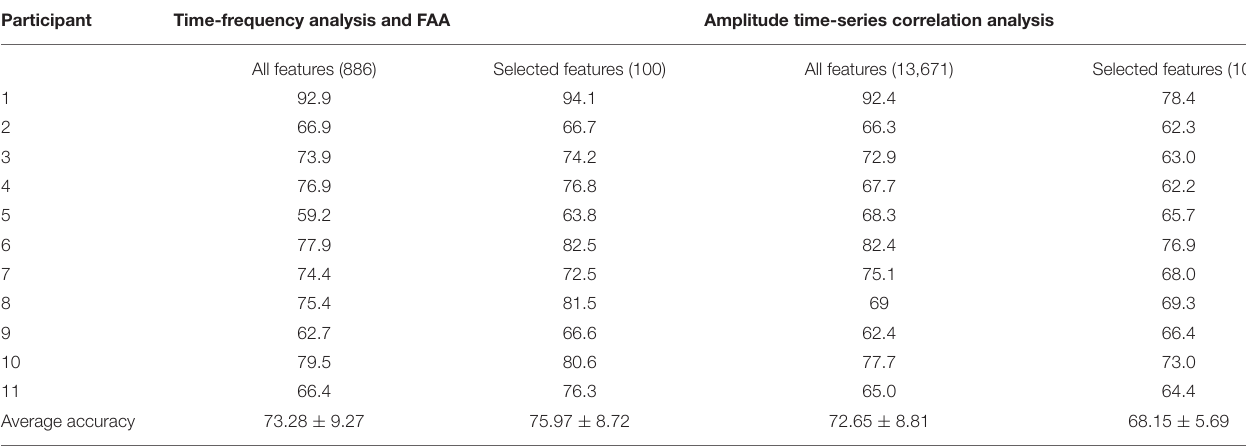
TABLE 2 | Classification accuracy in percent for each participant, feature extraction method, and the number of features. Participant Time-frequency analysis and FAA Amplitude time-series correlation analysis